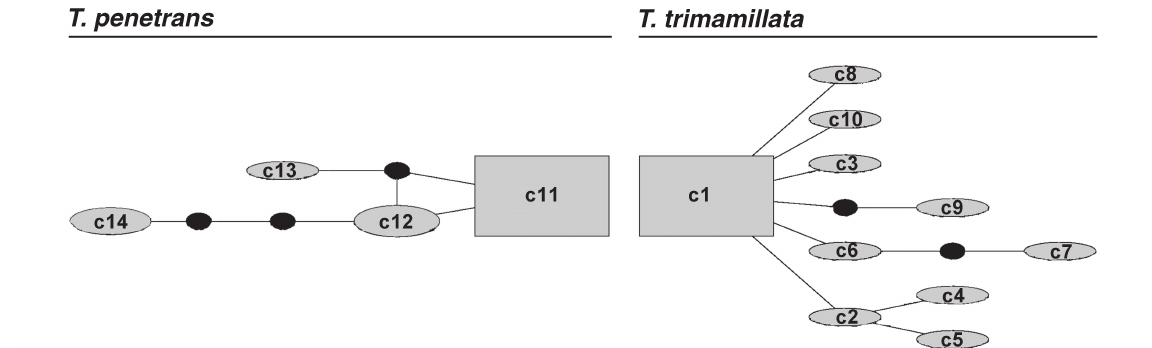
Fig. 2. – Networks for COII haplotypes observed in Tunga penetrans and T. trimamillata populations. The size of grey areas is propor- tional to the haplotype frequency; rectangles represent the estimated ancestral haplotype; black dots represent missing/ideal haplotypes. Haplotypes are as in Table